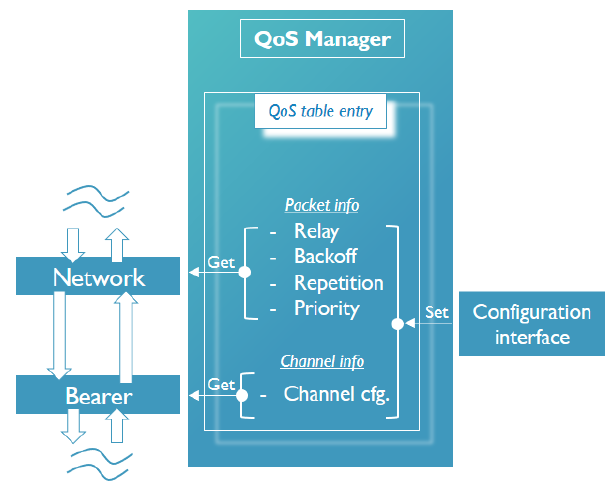
Figure 7. BLE mesh stack with added QoS features.